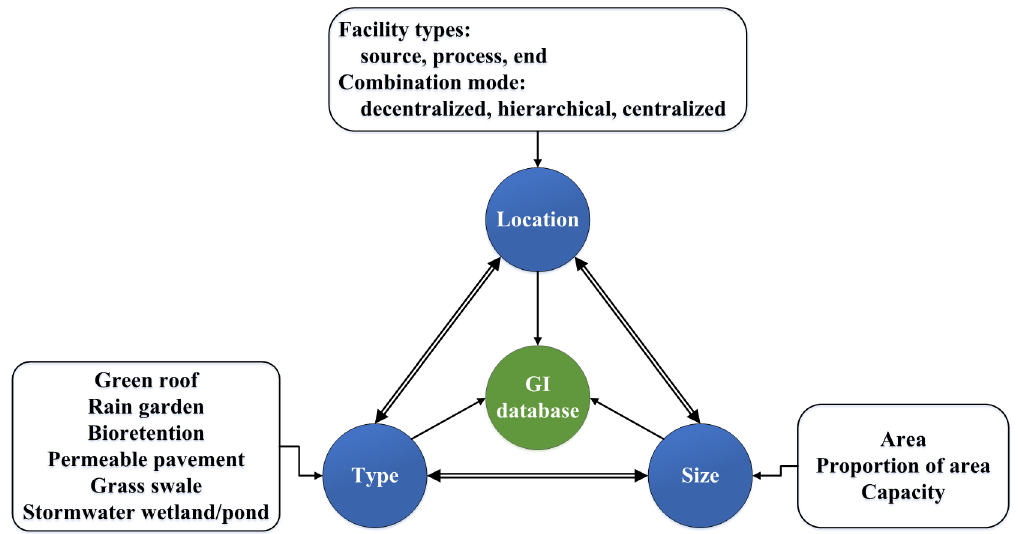
Figure 7. Illustration of the three main decision variables for GI optimization and their contents.